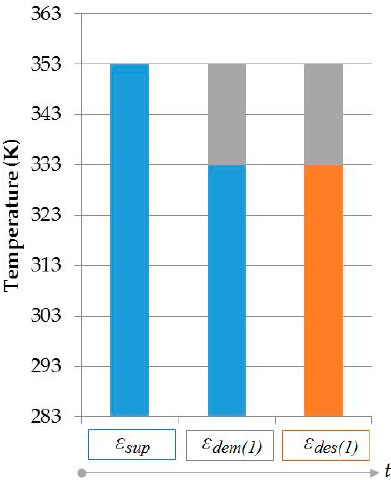
Figure 18. Exergy Flow Bars for Direct Geothermal Power with ORC.